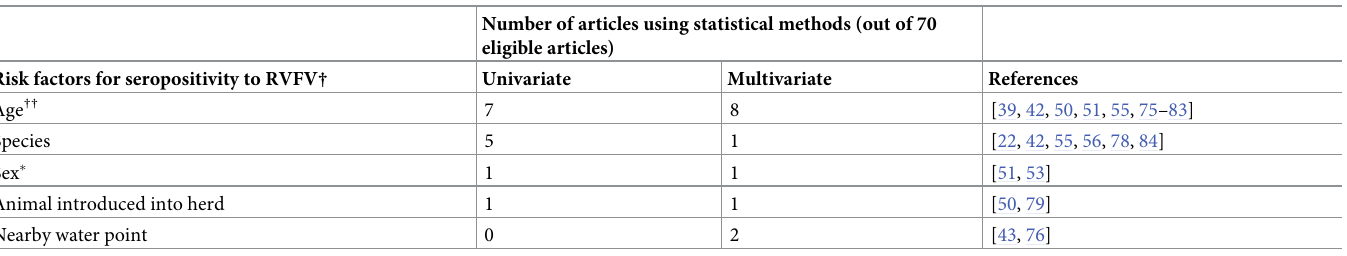
Table 3. Number of studies on livestock in Africa identifying potential risk factors as significantly associated seropositivity for Rift Valley fever virus (RVFV).